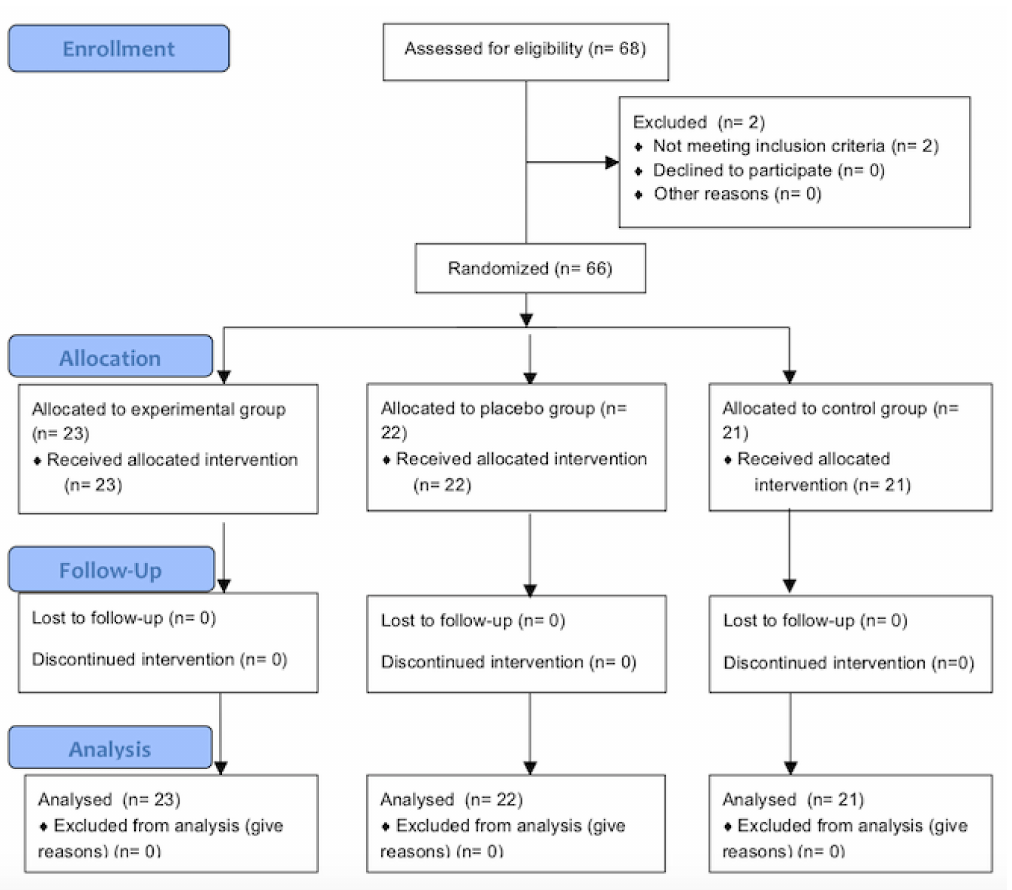
Figure 1. Flow diagram depicting flow of participants through each stage of the